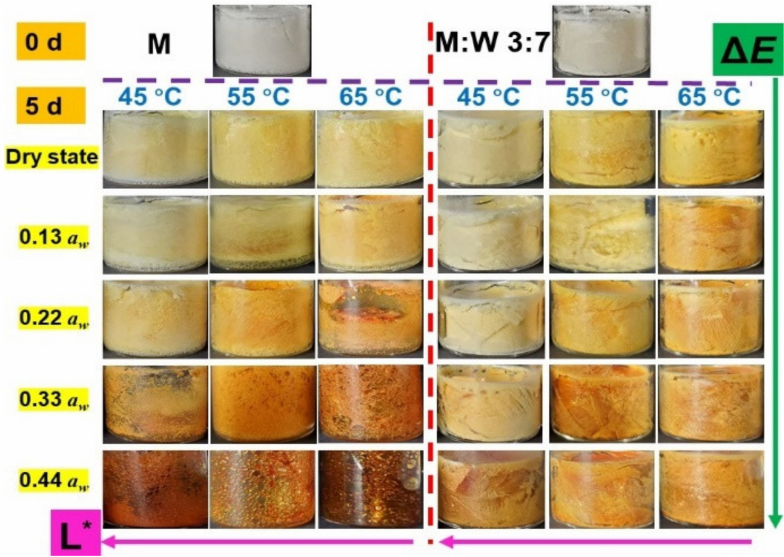
Figure 3. The color changes of the studied samples after storage under various conditions (0~0.44 a w and 45~65 ◦ C) at 5 days. The pure maltose and maltose/WPI (3:7, w / w ), which only experienced freeze-drying, were chosen as referencing